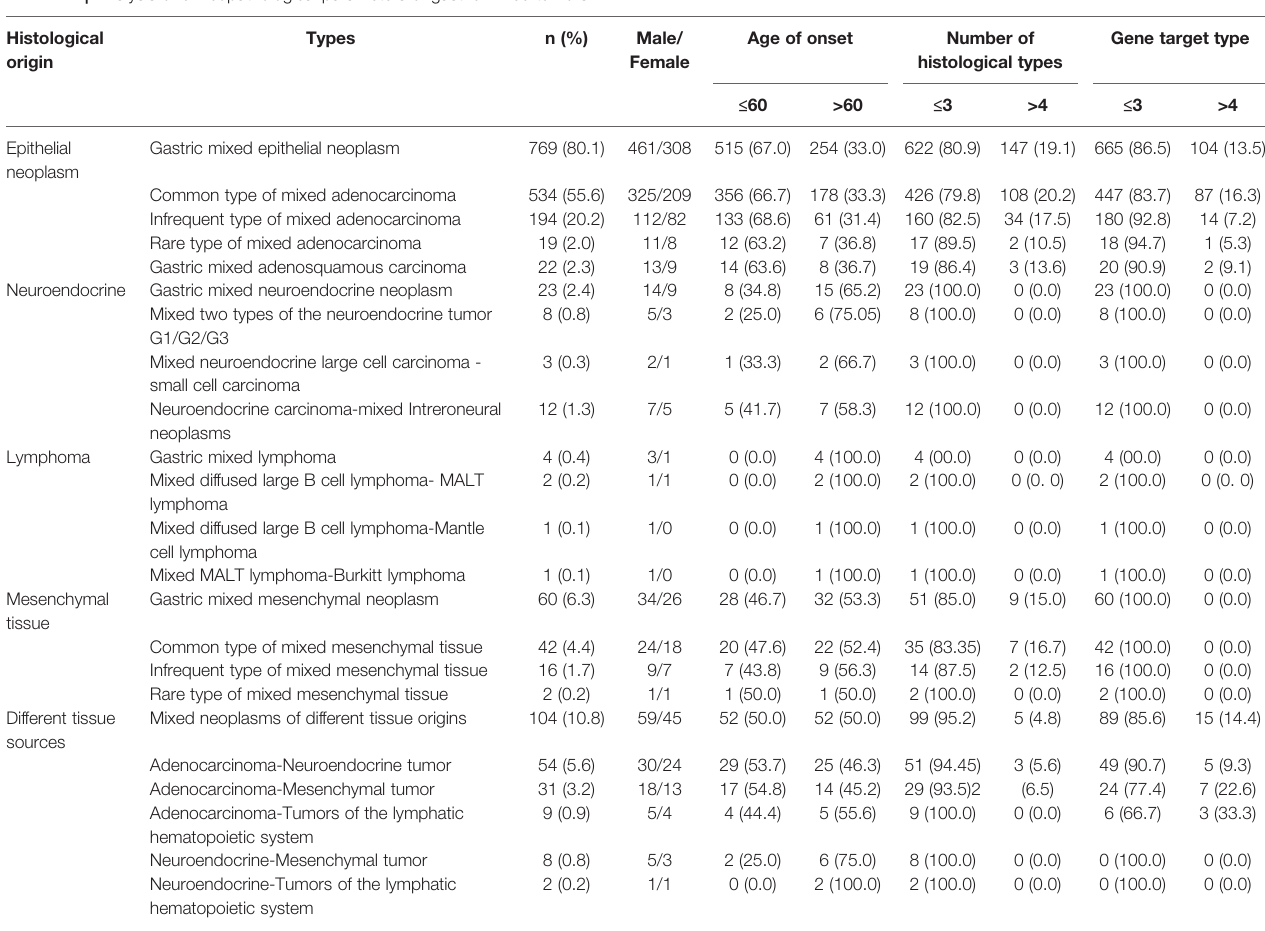
TABLE 1 | Analysis of clinicopathological parameters of gastric mixed